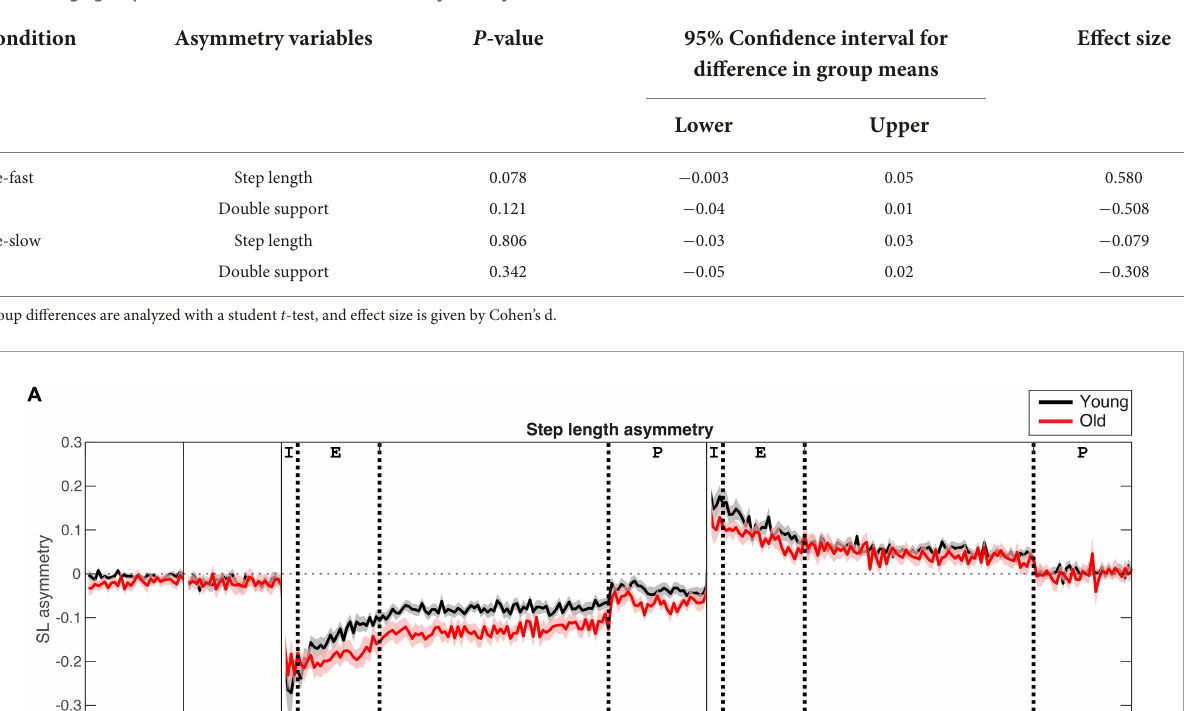
TABLE 2 Age group differences in baseline kinematic asymmetry.